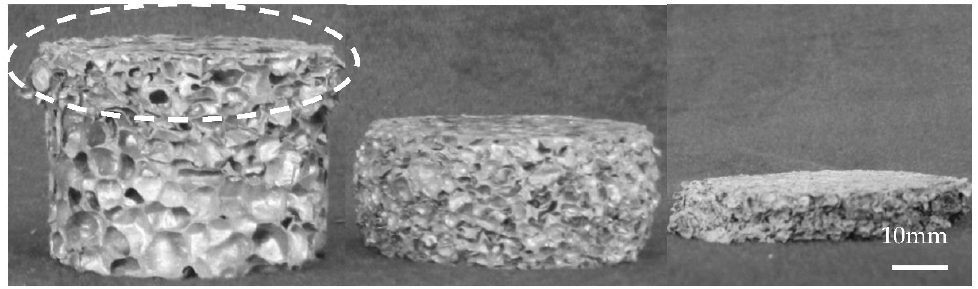
Figure 8. Deformation process of closed-cell Al foam with the density of 0.451 g/cm 3 under uniaxial impact velocities of 5 m/s.